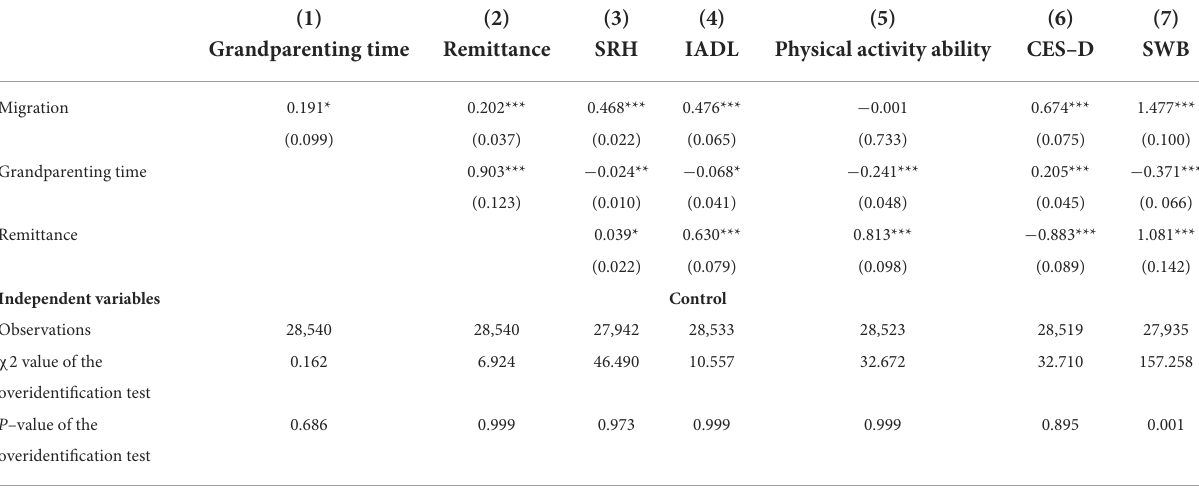
TABLE 5 Estimated results of the multiple–step, multiple mediator